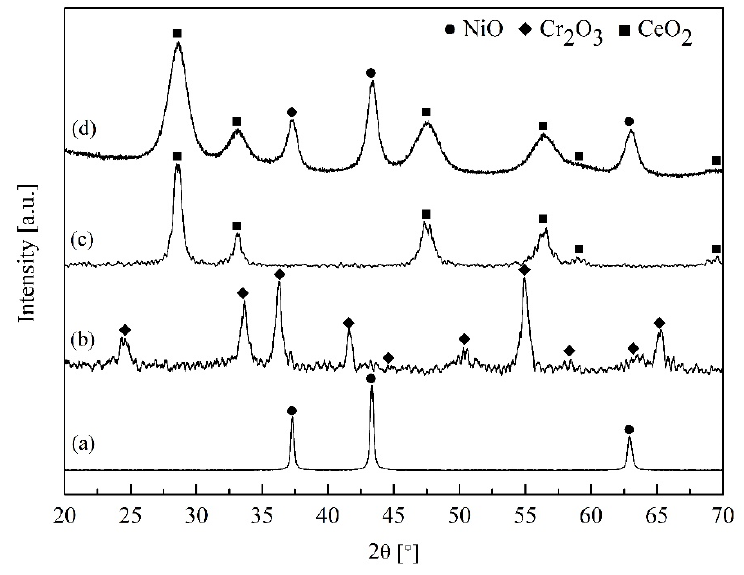
Figure 1. XRD patterns of ( a ) pure NiO ( ● ), ( b ) Cr 2 O 3 ( ▲ ), ( c ) CeO 2 ( ■ ) as an external standard for peak positions identification, and ( d ) 40 wt% Ni-CeO 2 /Cr 2 O 3 calcined at 500 °C.